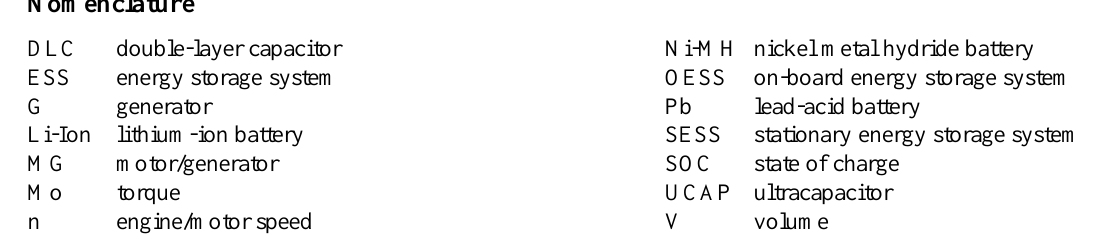
Drive operation characteristics (line in Fig. 15b) moves from zone A to zone